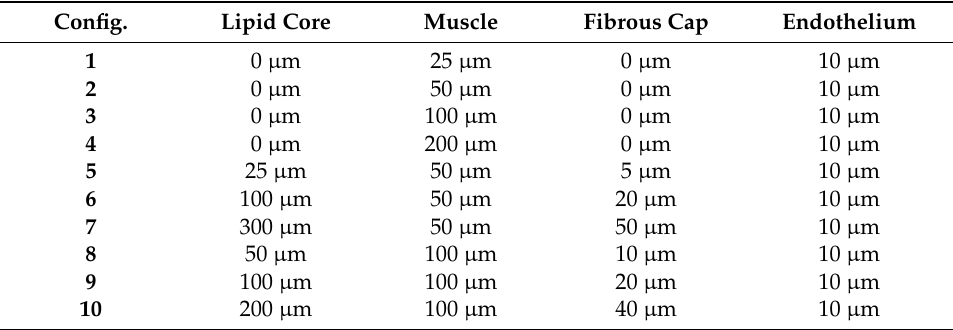
Table 5. Extended configurations of thicknesses of neointimal tissue layers.